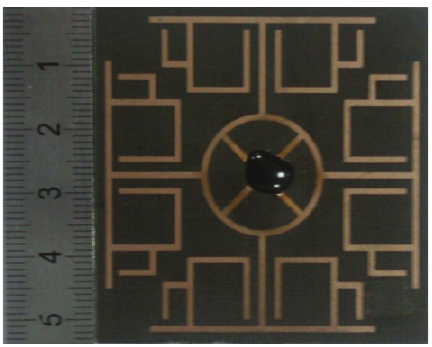
Figure 9: Photograph of the fabricated